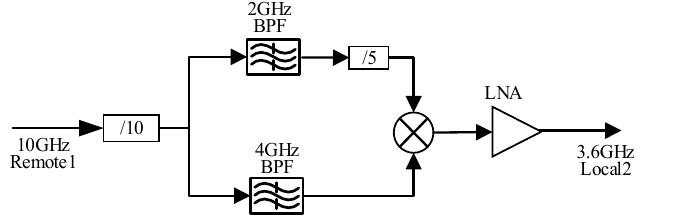
Figure 4. Scheme of the low-noise 10–3.6 GHz frequency conversion; LNA: low-noise amplifier; BPF: bandpass filter.